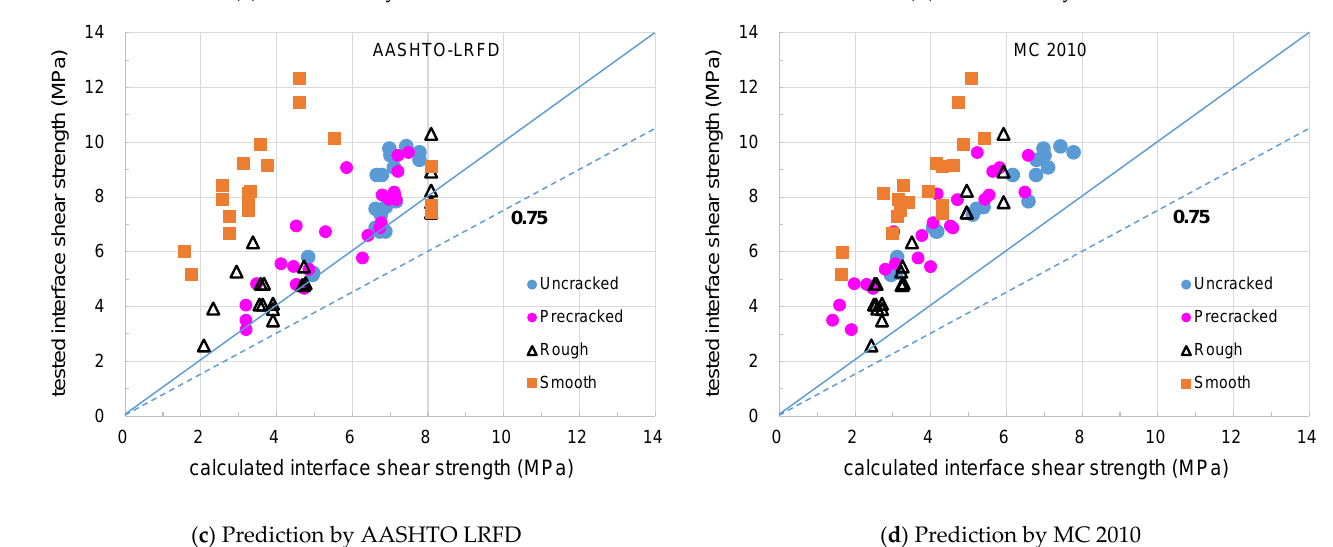
Figure 8. Comparison of tested and calculated interface shear strength for push-off test. Table 6 shows the distribution characteristics of the strength ratios of the flexural tests. The beam specimens were first divided into two groups of rough and smooth sur- faces, and then the rough surface was classified into Case 1 (horizontal shear transfer) and Case 2 (shear friction) categories. Table 6. Statistical analysis between design provisions and database from beam specimens.